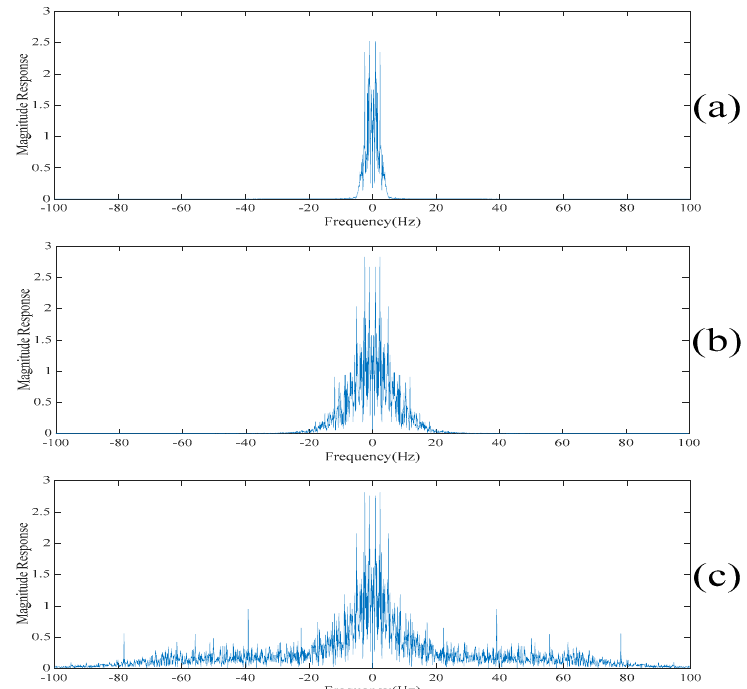
Figure 14. ( a ) The despiked electroencephalogram in the frequency domain reconstructed using the last five intrinsic mode functions. ( b ) The despiked electroencephalogram in the frequency domain reconstructed using the last seven intrinsic mode functions. ( c ) The despiked electroencephalogram in the frequency domain reconstructed using the last nine intrinsic mode